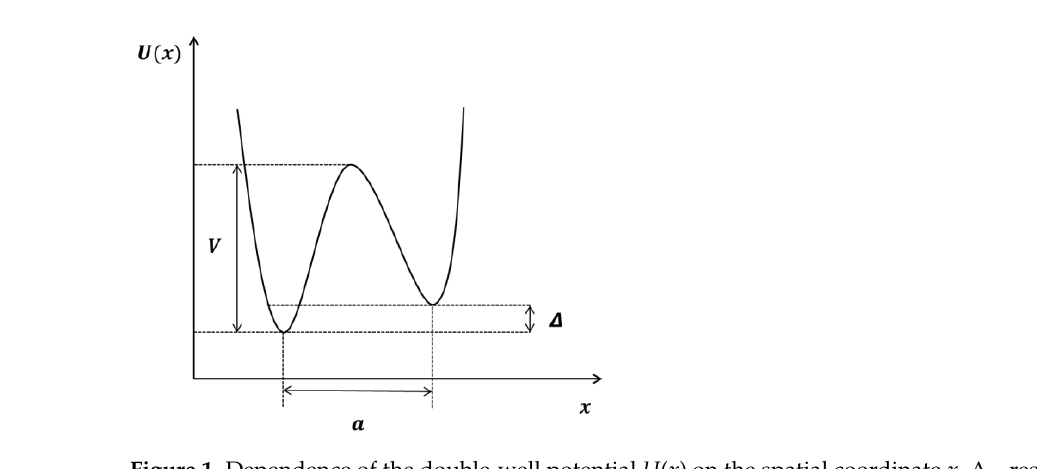
Figure 1. Dependence of the double-well potential U ( x ) on the spatial coordinate x . ∆ —resonance detuning; V —interwell barrier; a —width of the potential barrier.